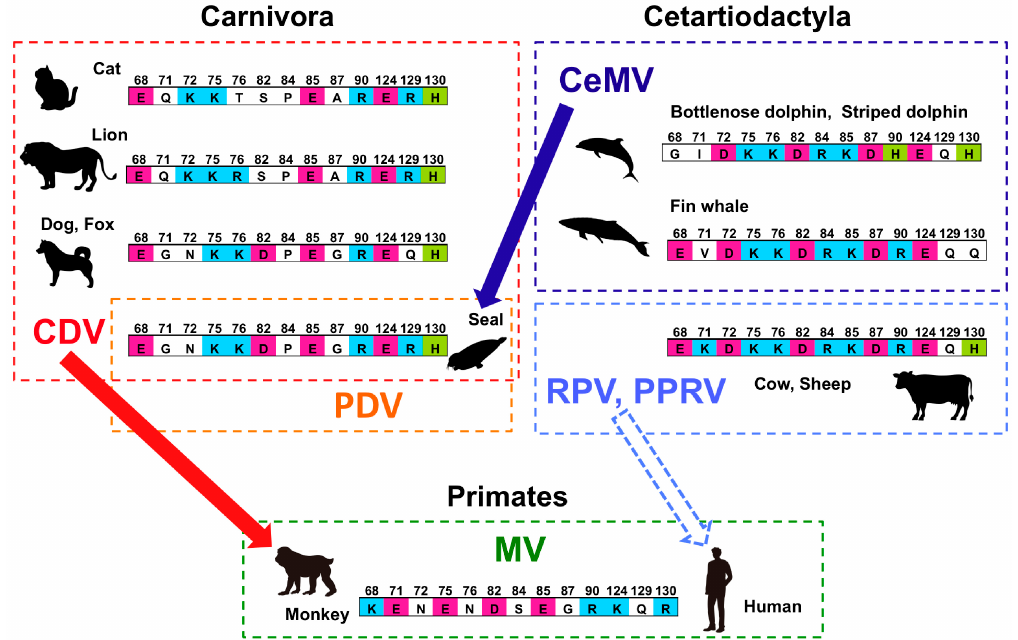
Figure 5. Schematic diagram of the relationships between morbillivirus species and their host animals. The hosts of each morbillivirus species are surrounded by dotted squares. The names of the various morbilliviruses are given in different colors. Residues of the 35-residue signaling lymphocyte activation molecule (SLAM) subsequence involved in hemagglutinin (H) protein binding that are not conserved among the host animal species are shown. Conserved residues or conservative amino acid substitutions are not shown. Thick colored arrows indicate recent host expansion beyond the order, and the dotted arrow indicates that the inferred transmission event during the evolution of MV.